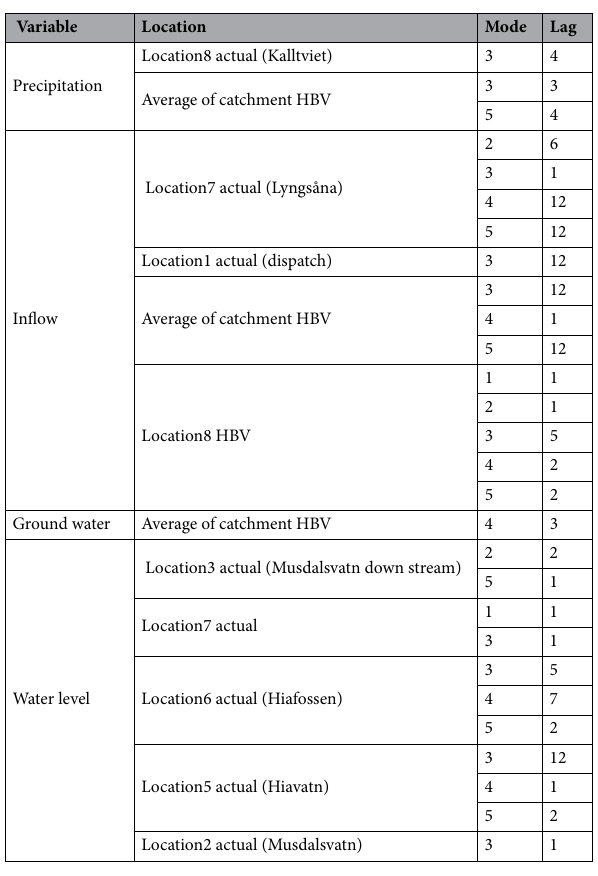
Table 2. Significant selected Modes by causal feature selection